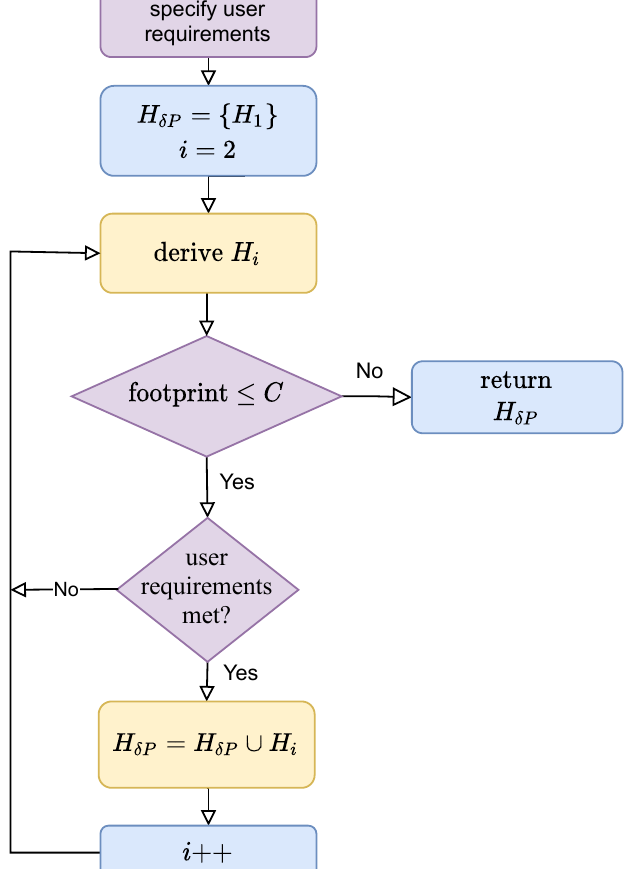
Figure 6. Flowchart of Pareto Optimization. Our approach first finds the CNN, H 1 , whose accuracy α ( H i ) ≥ α min (the user- specified minimum accuracy) and its execution time is not longer than